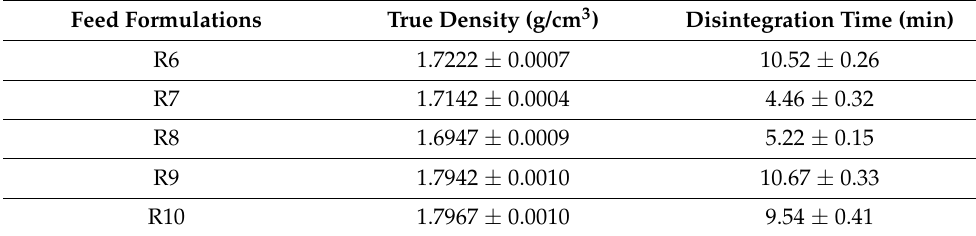
Table 3. True density and tablet disintegration of CCK of